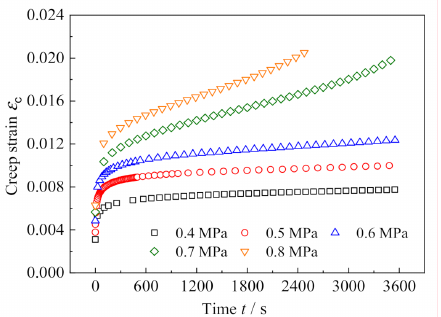
Figure 4. Creep strain vs. time curves at various stresses.